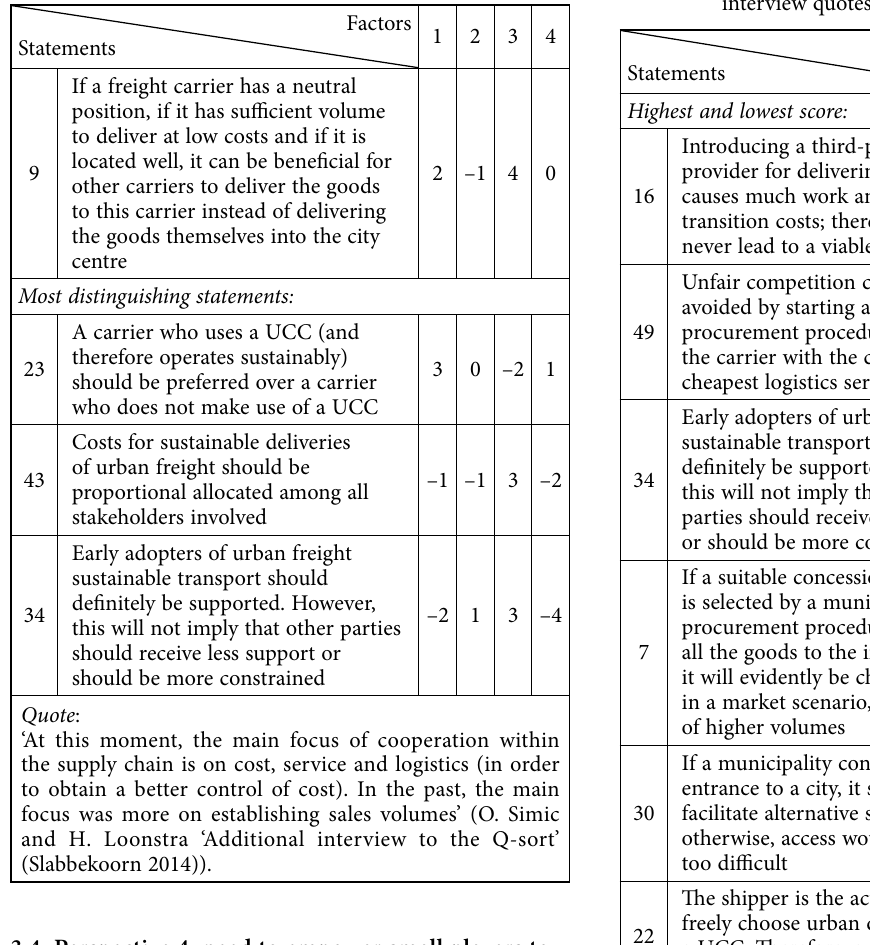
Table 7. Q-sort values for statements and